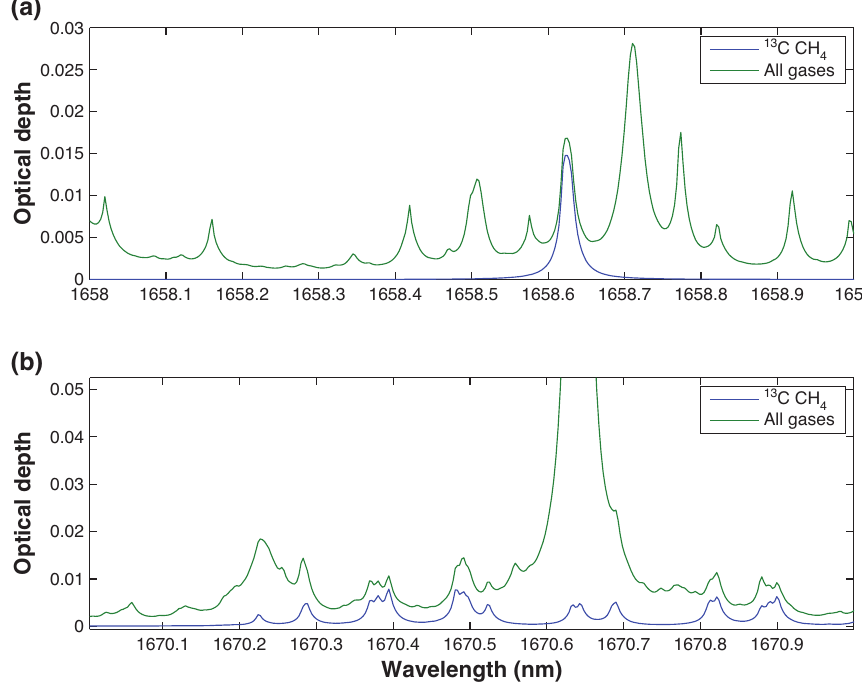
Figure 4 Optical depth covering 13 Ch 4 absorption points of interest, the green line represents optical depth of all gases present in this portion of the spectrum (Ch , 4 CO and h O), whilst the blue line 2 2 shows optical depth of purely the methane isotopologue 13 Ch : 4 (a) indicates optical depth in the wavelength range 1658–1659 nm; (b) shows optical depth in the wavelength range 1670–1671 nm. This figure is as figure 5 in [27], but has been updated to reflect the use of hiTRAN2016.